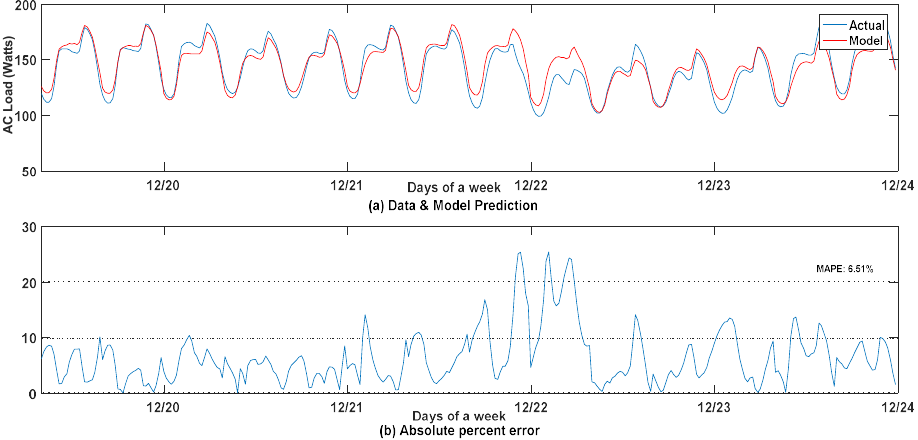
Figure 9. Comparison of forecast and actual load for every week.